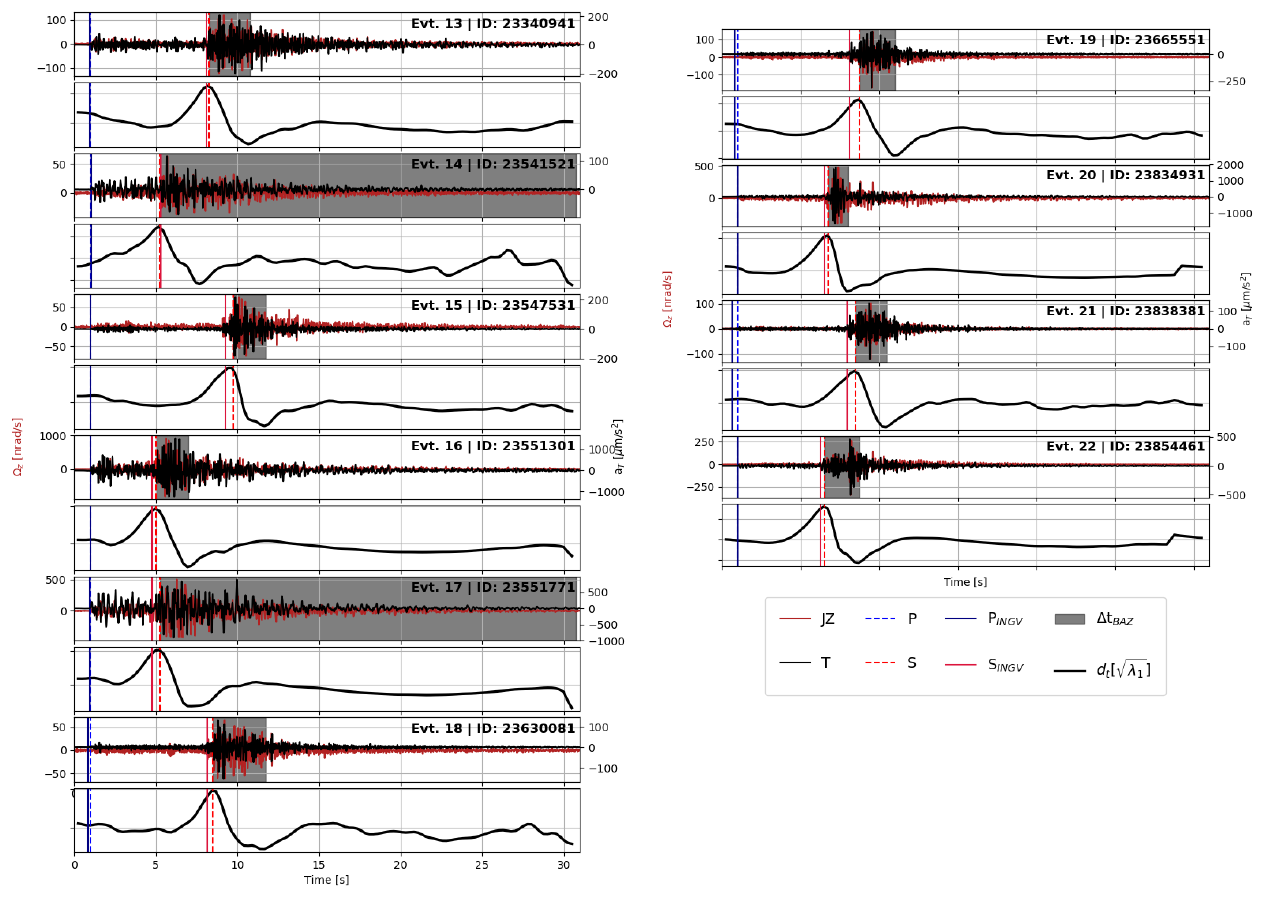
Figure 5. The analyzed events, from top: odd panels are a superposition of transverse acceleration (in black) and vertical rotation rate (in red), even panels the time derivative of the principal eigenvalue used for Sh waves phase picking. The latter is normalized with respect to its maximum value. Vertical lines indicate arrival times (P waves in blue, Sh waves in red) as picked by the routine used in this study (dashed lines) and published by the INGV (continuous lines). See explanation in the text for polarization